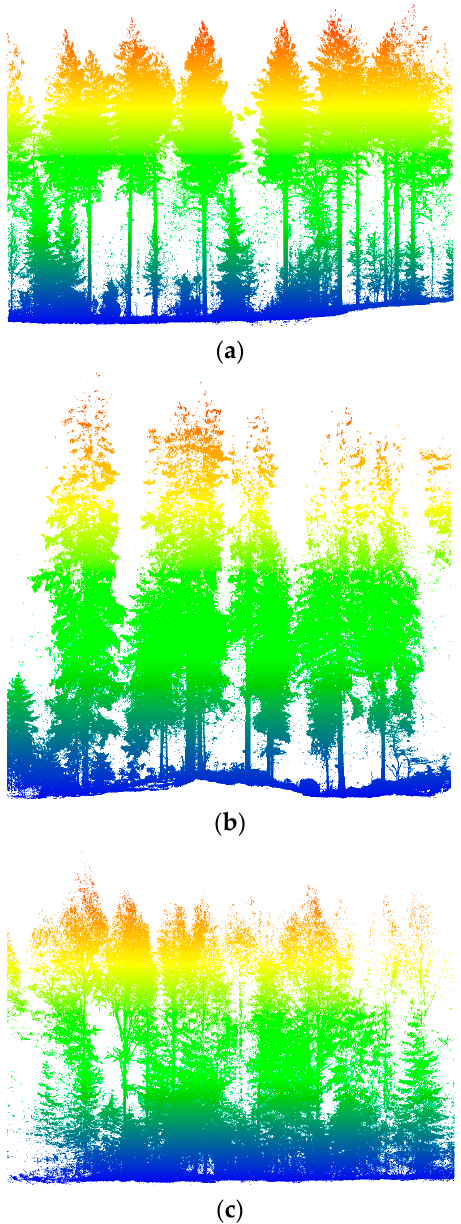
Figure 1. Cross-sections of the International TLS Benchmark datasets which demonstrate that the segmentation difficulty rating corelates with forest structure complexity. ( a ) ‘Easy’; ( b ) ‘Intermediate’; ( c ) ‘Difficult’. Points are colored based on relative height.